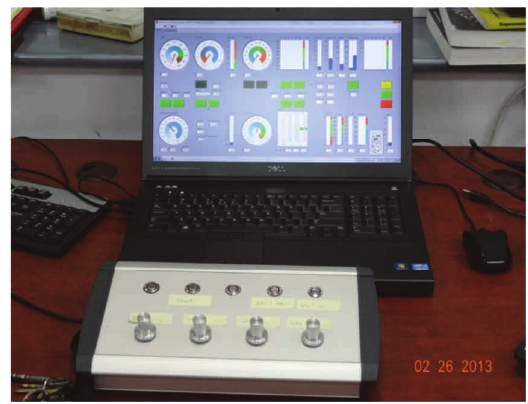
Fig. 4. General view of the control panel of the programmable controller